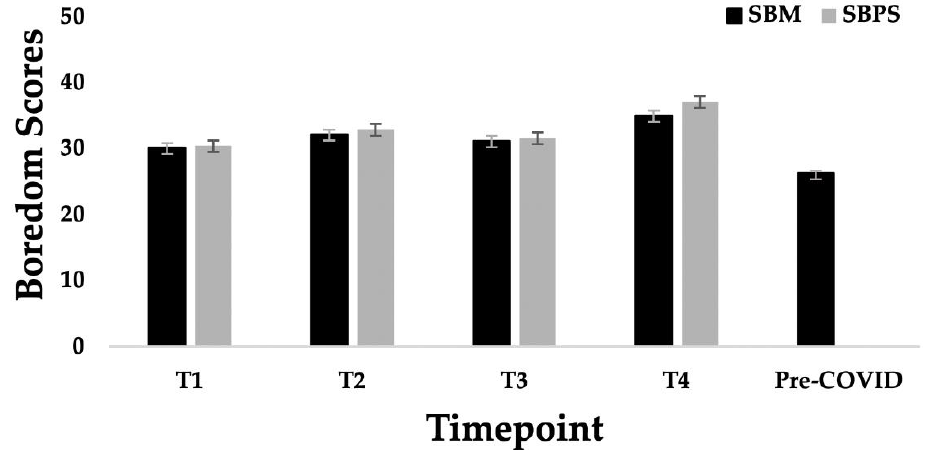
Figure 1. Differences in state boredom and boredom proneness across time points. Error bars represent standard error; T1 = time point 1; T2 = time point 2; T3 = Time point 3; T4 = Time point 4; SBM = State Boredom Measure; SBPS = Short Boredom Proneness Scale. Table 2. Descriptive Statistics for Boredom at Each Time Point.